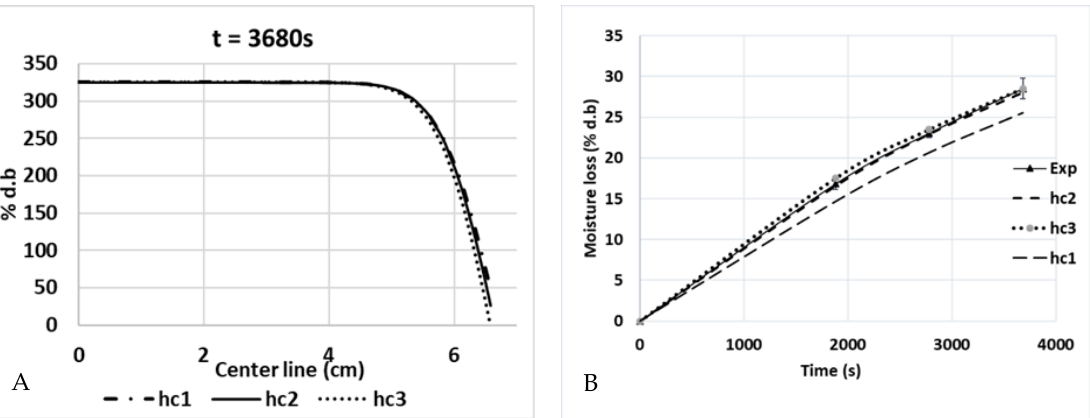
Figure 15. Water concentration profiles (% d.b.) along a central cut-line from the top surface to the bottom ( A ), and global moisture loss during cooking ( B ) ( hc 1 = 3.5 W/(m 2 ∙ K), hc 2 =6 W/(m 2 ∙ K), and hc 3 = 8.4 W/(m 2 ∙ K)).